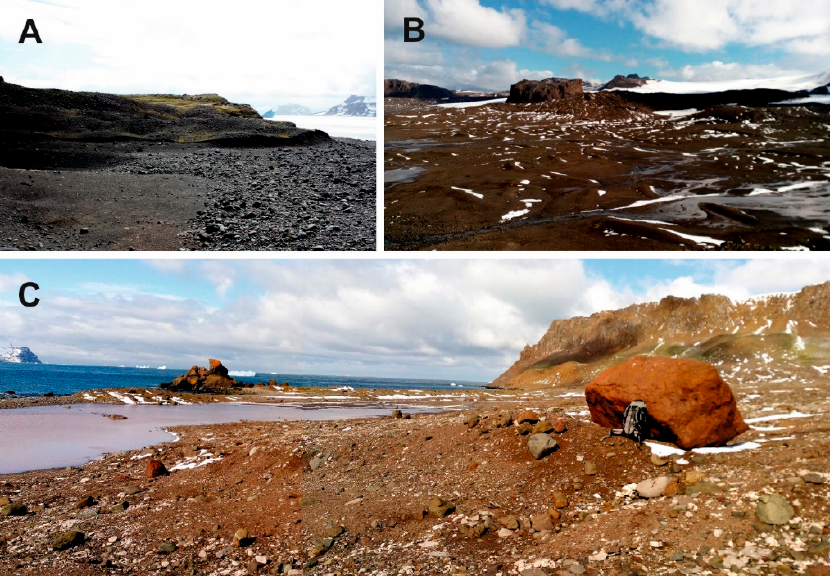
Figure 8. Photographic documentation of selected landforms (phot. G. Rachlewicz, 2016): A—an outwash and the young latero-frontal moraine complex deposited in the northern part of Ecology Glacier foreland; the older latero-frontal moraine complex (overgrown with mosses) is seen in the background; moraines are undercut by coastal erosion; B—large recessional end moraine ridges and an outwash deposited within the ground moraine complex on the Sphinx Glacier foreland are visible on the foreground; the shaded long ridge in the background is Błaszyk Moraine (medial moraine), and the table mountain is a former nunatak Siodło in the Baranowski Glacier foreland; C—a fluted moraine of the Baranowski Glacier foreland and a transfluent lake enclosed by a storm ridge, collecting waters from two glacial rivers; high slopes of Demay Point are seen in the background.